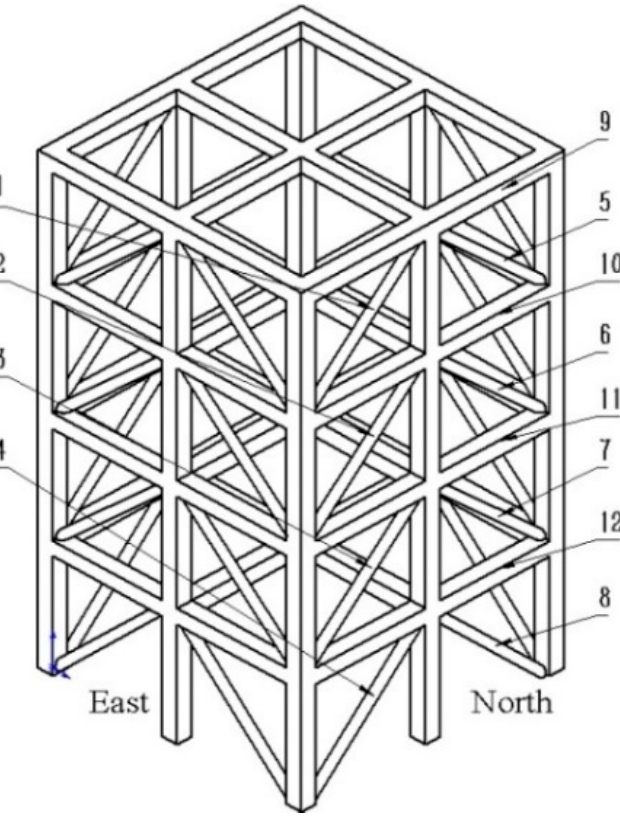
Figure 1. Frame structure model.